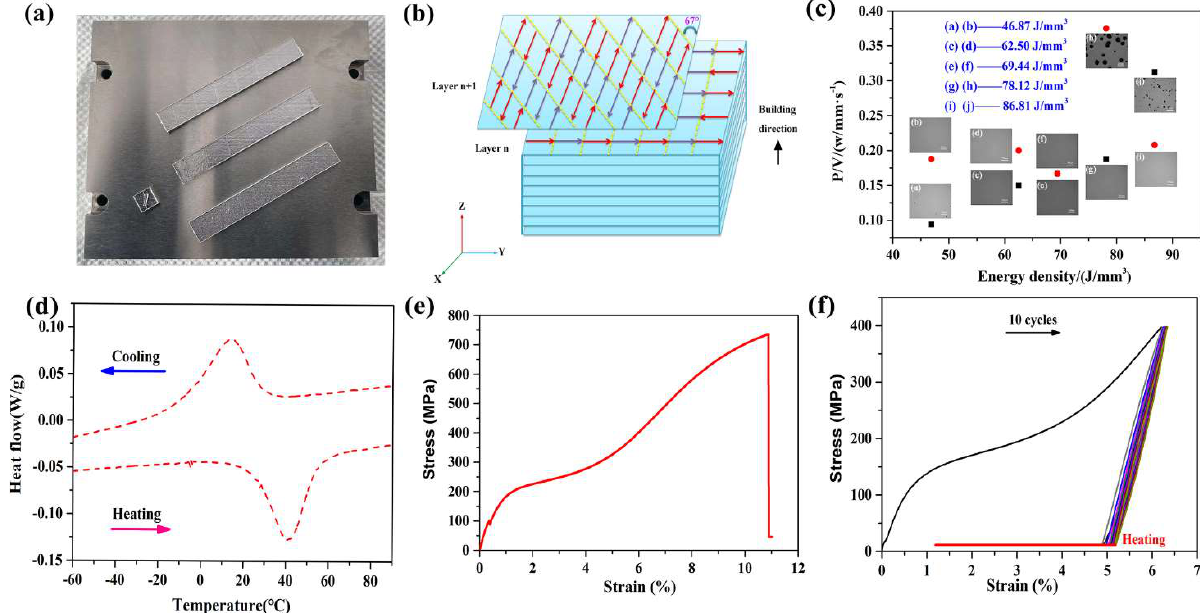
Figure 1. ( a ) 3D printing NiTi alloy samples; ( b ) Schematic diagram of printing strategy; ( c ) Surface forming quality of samples with different parameters under the optical microscope; ( d ) DSC curve; ( e ) Tensile fracture curve; ( f ) Heating recovery curve after ten cycles [10].